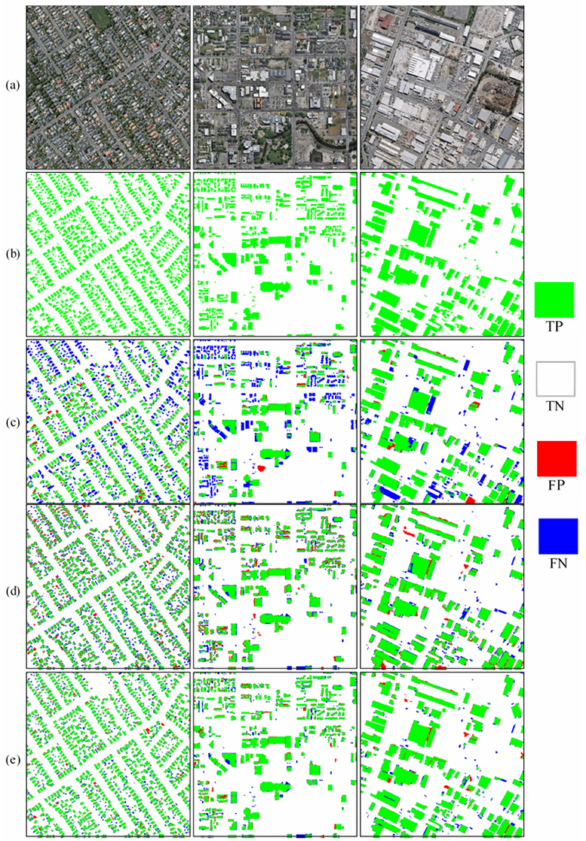
Figure 16. Results of building footprint segmentation from large-scale remote sensing images.